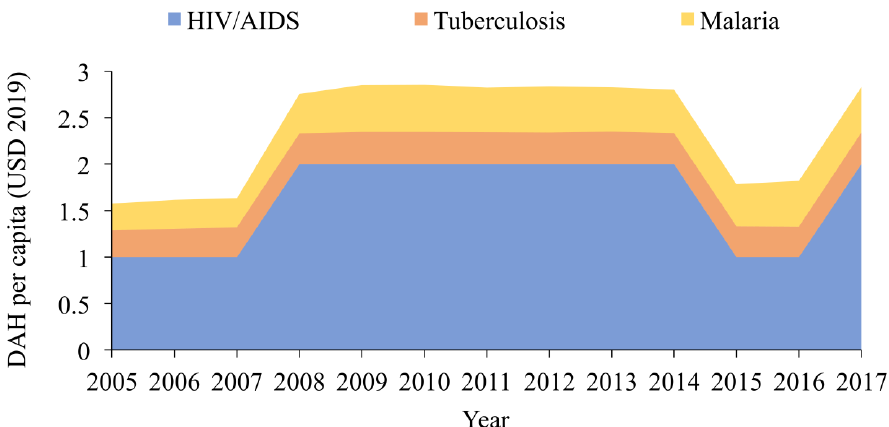
Figure 2. Stacked area chart, development assistance for health per capita to HIV/AIDS, TB and malaria, 2005 – 2017 (unit of y-axis: 10 million of 2019 USD, DAH = development assistance for health). Table 2. Associations between development assistance for health and disease burden (in 2005 and 2017) *.